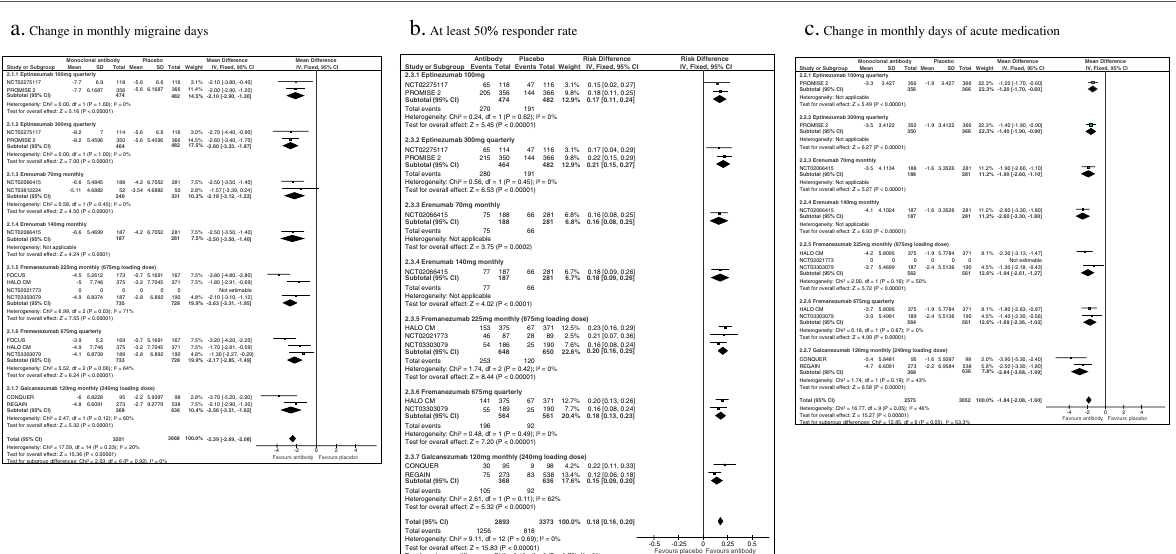
Duration of all the studies is expressed in weeks and transformed as appropriate from the original study (m) indicates monthly, (q) indicates quarterly, ld indicates loading dose a The 675 mg loading dose did not enter clinical practice; however, it was tested in all trials of the 225 mg monthly dose. The difference between trials tested dose and clinical practice dosing was considered in the evaluation of quality of evidence and lead to a downgrade